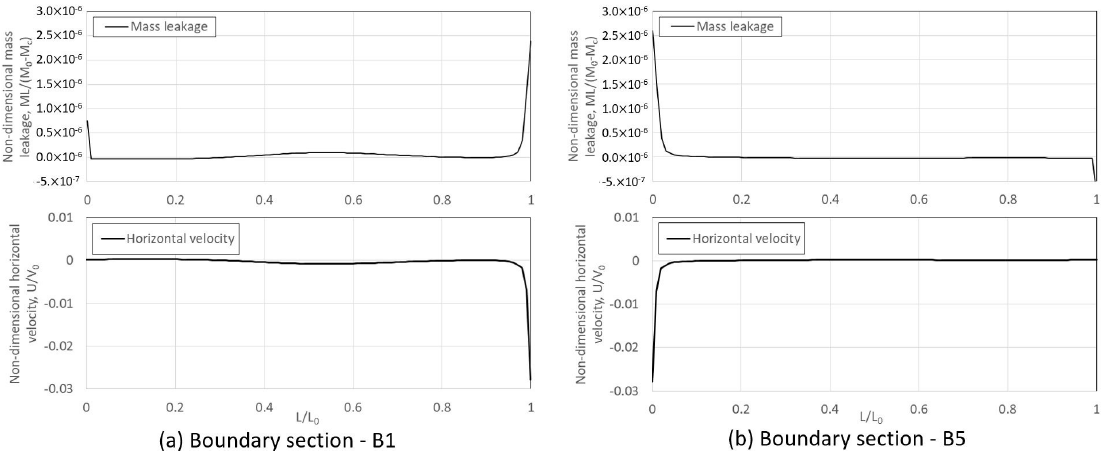
Figure 7. Non-dimensional ML and horizontal velocity components along different boundaries: ( a ) B1; ( b ) B5.